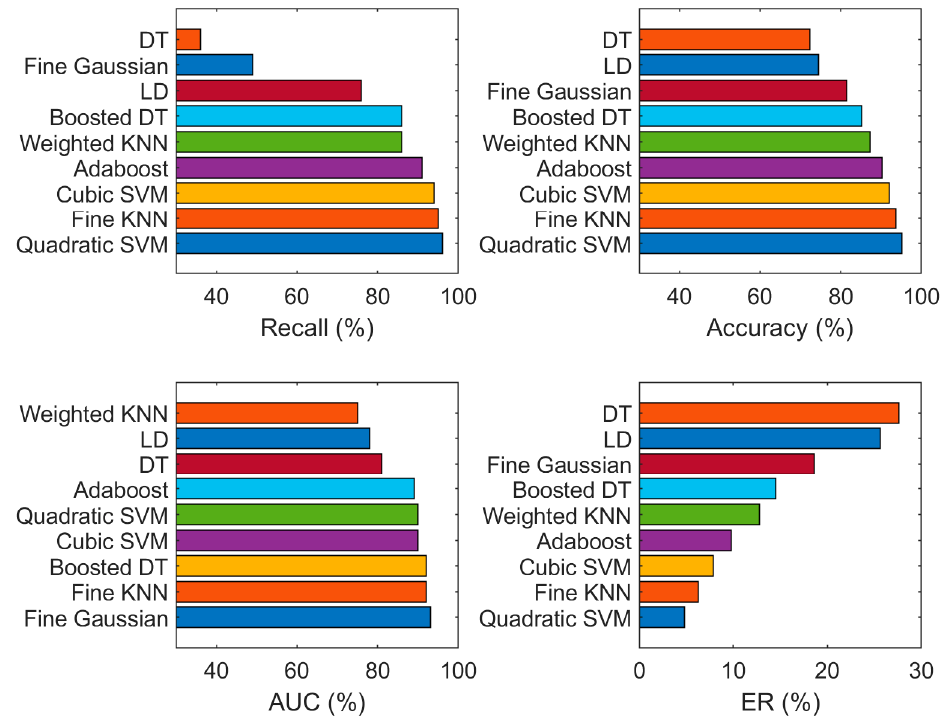
Figure 7. Classification results (recall, accuracy, AUC and ER) using SFTA features on the original (imbalanced) dataset.